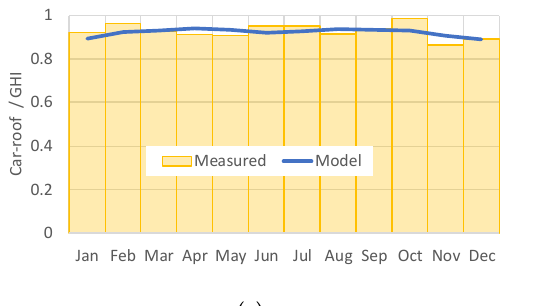
Table 2. Comparison of model and measurement (relative to GHI) by one-year monitoring of a passenger’s car.